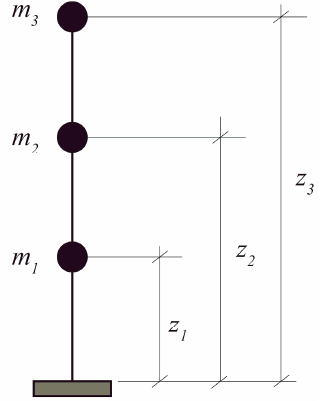
Figure 3. Frame as a stick-model series